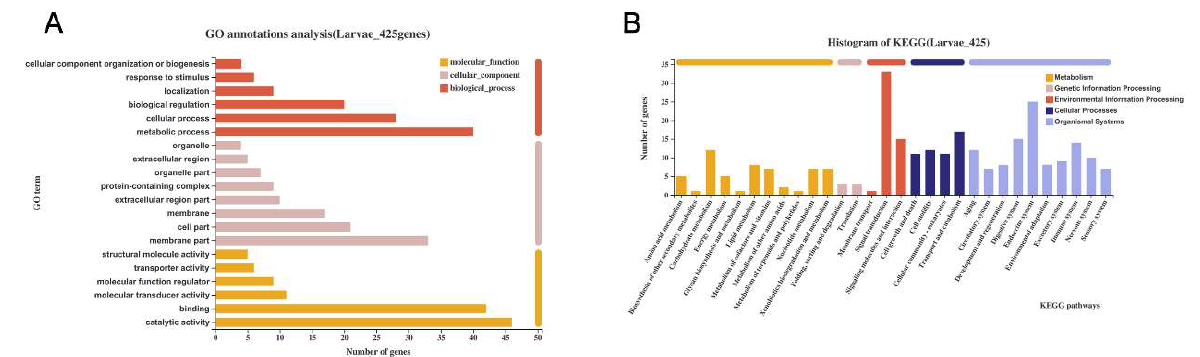
Figure 6. GO annotation and KEGG analysis of gene expressed during silkworm larval stages. ( A ) GO annotation of the genes expressed during silkworm larval stages. ( B ) KEGG analysis of gene expression during silkworm larval stages.